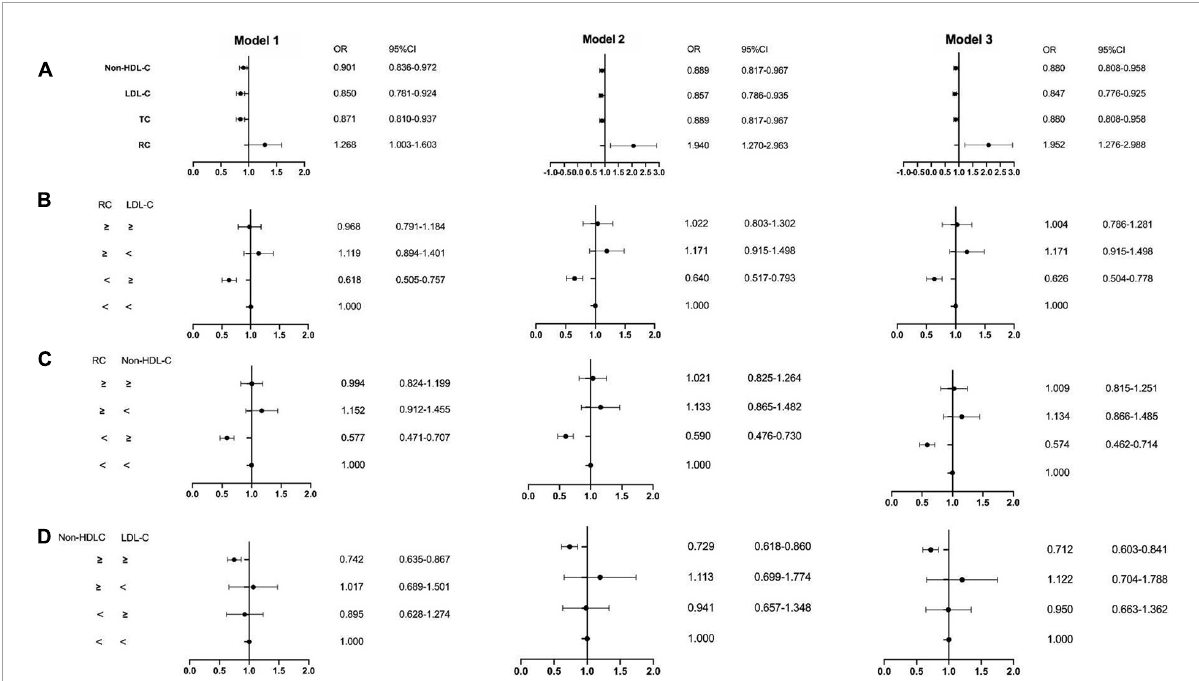
FIGURE2 The result of multivariable logistic regression analyze. Model 1: age, gender, hypertension, hypercholesterolemia, smoking, diabetes, BMI; Model 2: Model 1, SBP, DBP, FBG, HbA1C, HDL-C, TG; Model 3: Model 2, creatinine, uric acid, hs-CRP, BNP, WBC, homocysteine. The medians of the RC, LDL-C and non-HDL-C index were calculated to divide all patients into two different groups: low (less than the medians) and high (equal to or greater than the medians). Then patients were categorized into four groups according to having a low or high RC index and LDL-C, RC and non-HDL-C, non-HDL-C and LDL-C as follows: low/low, low/high, high/low, and high/high. (A) Non-HDL-C, LDL-C, TC and RC; (B) RC and LDL-C group; (C) RC and non-HDL-C group; (D) non-HDL-C and LDL-C group. LDL-C, low-density lipoprotein cholesterol; HDL-C, high-density lipoprotein cholesterol; RC, remnant cholesterol; OR, odds ratios; CI, confidence intervals. Modified from Wang et al.